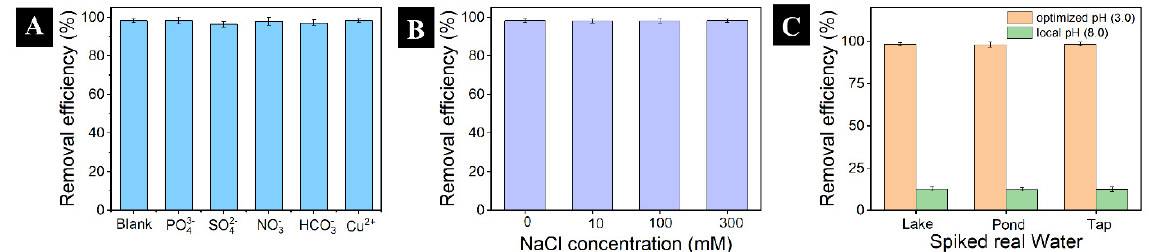
Figure 7. Effects of co − existing ions ( A ), effects of ionic strength ( B ) and the elimination of V(V) in real water samples ( C ). Conditions ( A,B ): V(V) initial concentration = 100 ppm V(V), and 60 ppm PO 4 3 − , 600 ppm SO 4 2 − , 400 ppm NO 3 − , 400 ppm HCO 3 − and 60 ppm Cu 2+